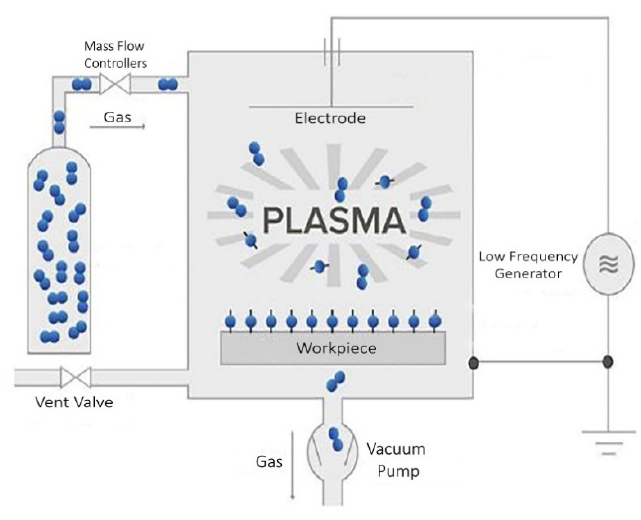
Figure 1. Schematic diagram of the plasma system (PICO) .